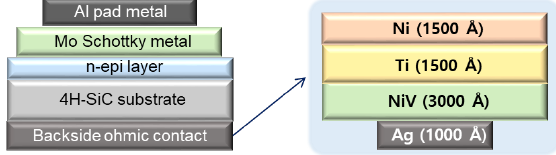
Figure 2. Structure of as-fabricated Mo / SiC Schottky diode. Table 1. Deposition conditions.